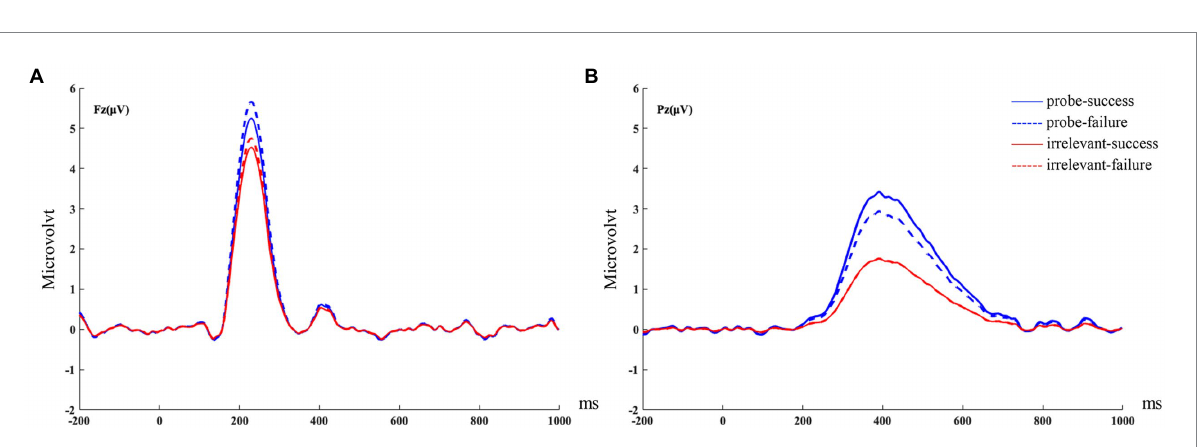
FIGURE 4 PCA-extracted ERP waveforms of FRN (A) and feedback-P300 (B) during feedback stage combining guilty and innocent group.